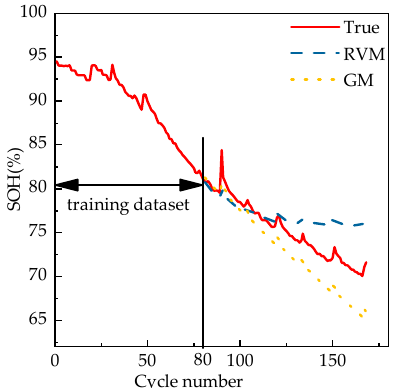
Figure 2. Relevance vector machine (RVM) and gray model (GM) prediction curve starting prediction at the cycle 80 of the #5 battery.